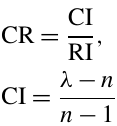
Table 3. The AHP pairwise comparison matrix for the domestic rainwater harvesting suitability